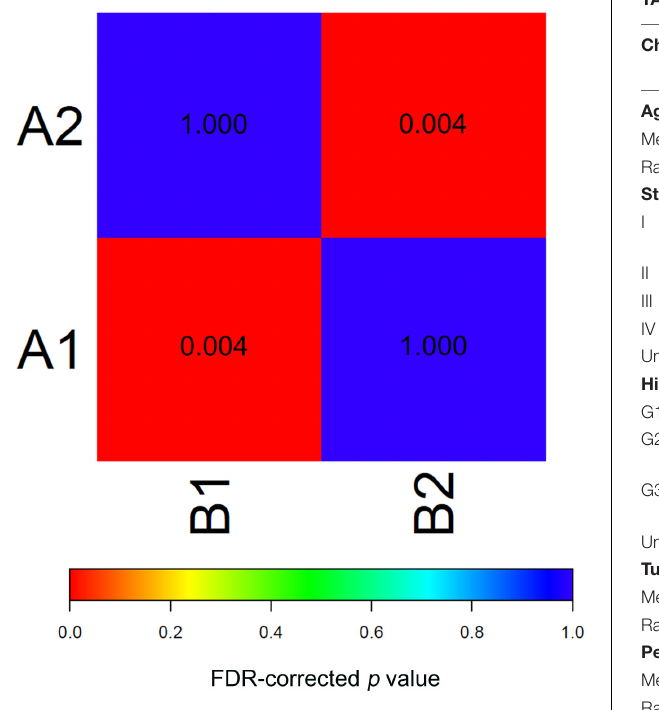
FIGURE 3 | SubMap association matrix among TCGA (subtype A1 and subtype A2), GSE32507 (subtype B1 and subtype B2), P -value is corrected with